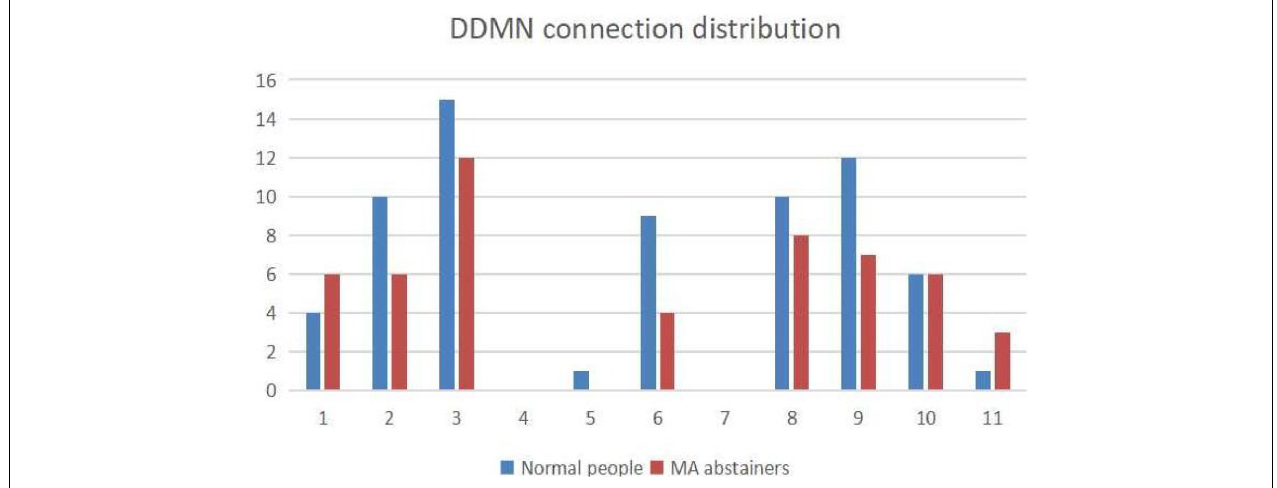
FIGURE 8 | The figure shows the distribution of connection with each brain network in DDMN. The numbers 1–11 represent the corresponding brain networks: ASN, HVN, PSN, DDMN, PN, VDMN, LN, VN, RECN, SN and AN. The blue histogram indicates the number of normal people’s connections in this brain network, and the red histogram indicates the number of MA abstainers’ connections in this brain network.